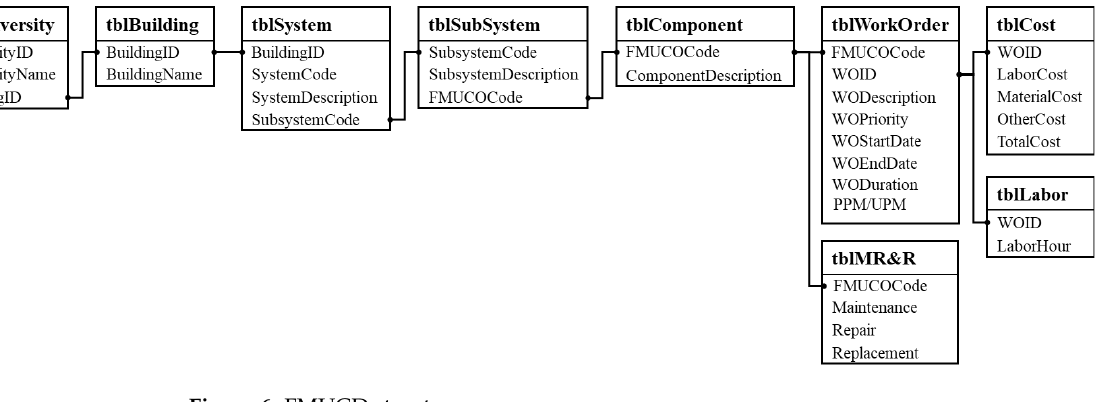
Figure 6. FMUCD structure.